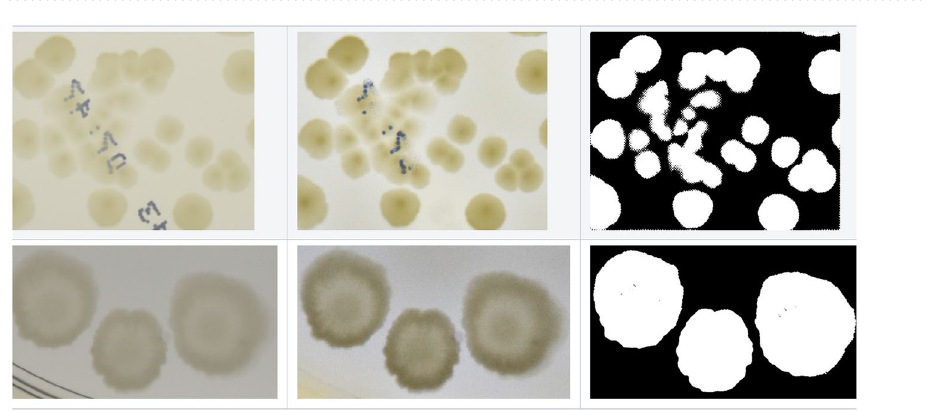
Figure 3. Example patch segmentation (binary masks m s on the right) using the Chan–Vese